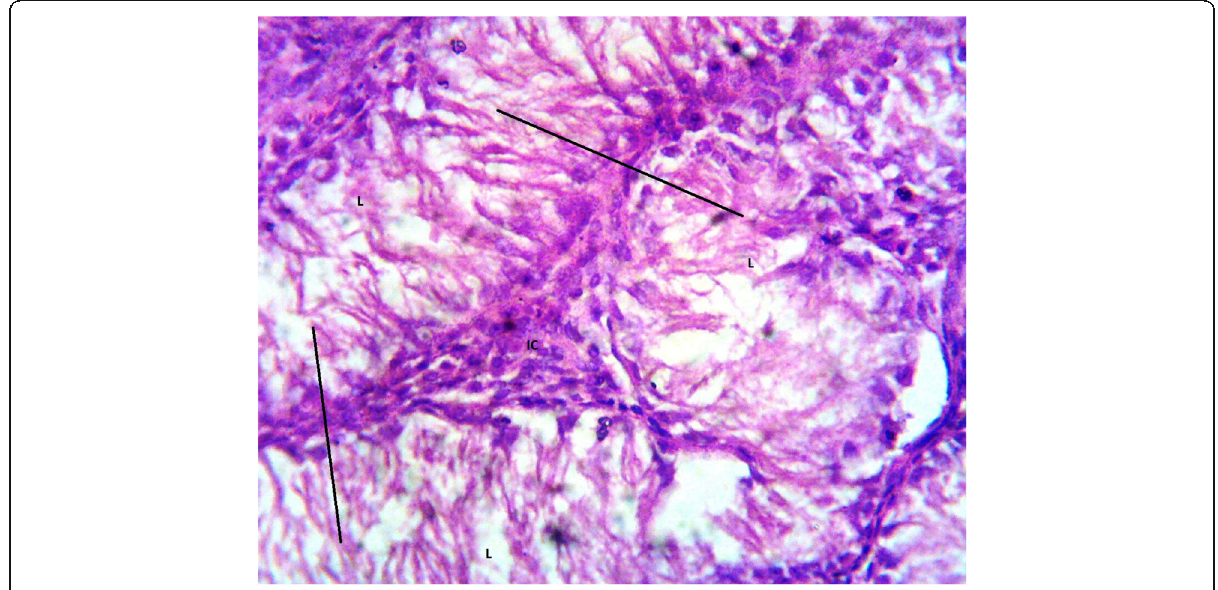
Fig. 10 Representative micrograph of testis section (× 400) of broiler chicks fed 0.6% PCM supplemented diet. This section shows reduced spermatogenic activities in the seminiferous tubules. (Line), L lumen, IC interstitial